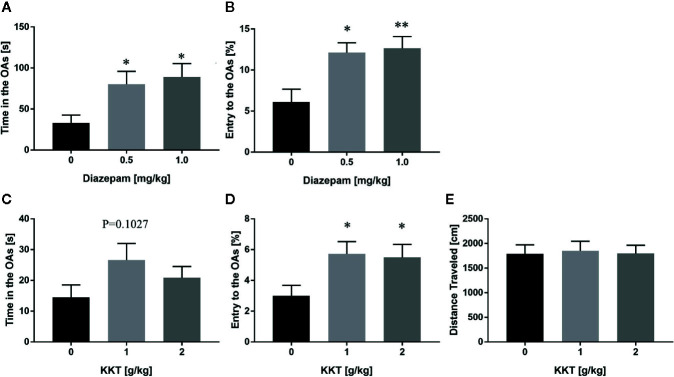
Anxiolytic effects of KKT on C57BL/6J mice in the conventional EPM. (A, B) Effect of single administration of diazepam on time spent (A) and percentage of entries (B) in the OAs (n = 7–8). (C–E) Effects of repeated KKT treatment on time spent in the OAs (C), the percentage of OA entries (D), and total distance traveled in all arms (E) (n = 17–18). All data are presented as mean ± SEM. *: P < 0.05; **: P < 0.01 (versus the vehicle-administered group), Dunnett’s test.